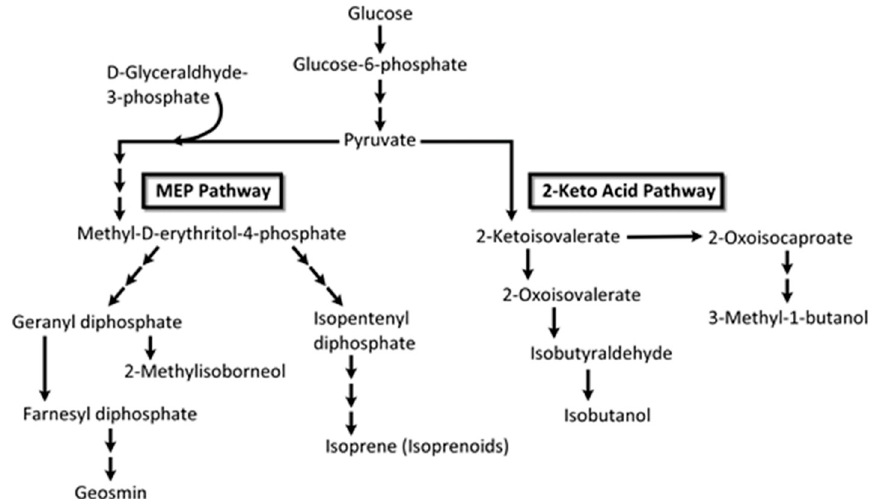
Figure 10. Interconnectivity of metabolic pathways. MEP, methyl- D -erythritol-4-phosphate. Regardless of metabolism, the biosynthesis of VOCs occurs through the formation of pyruvate.